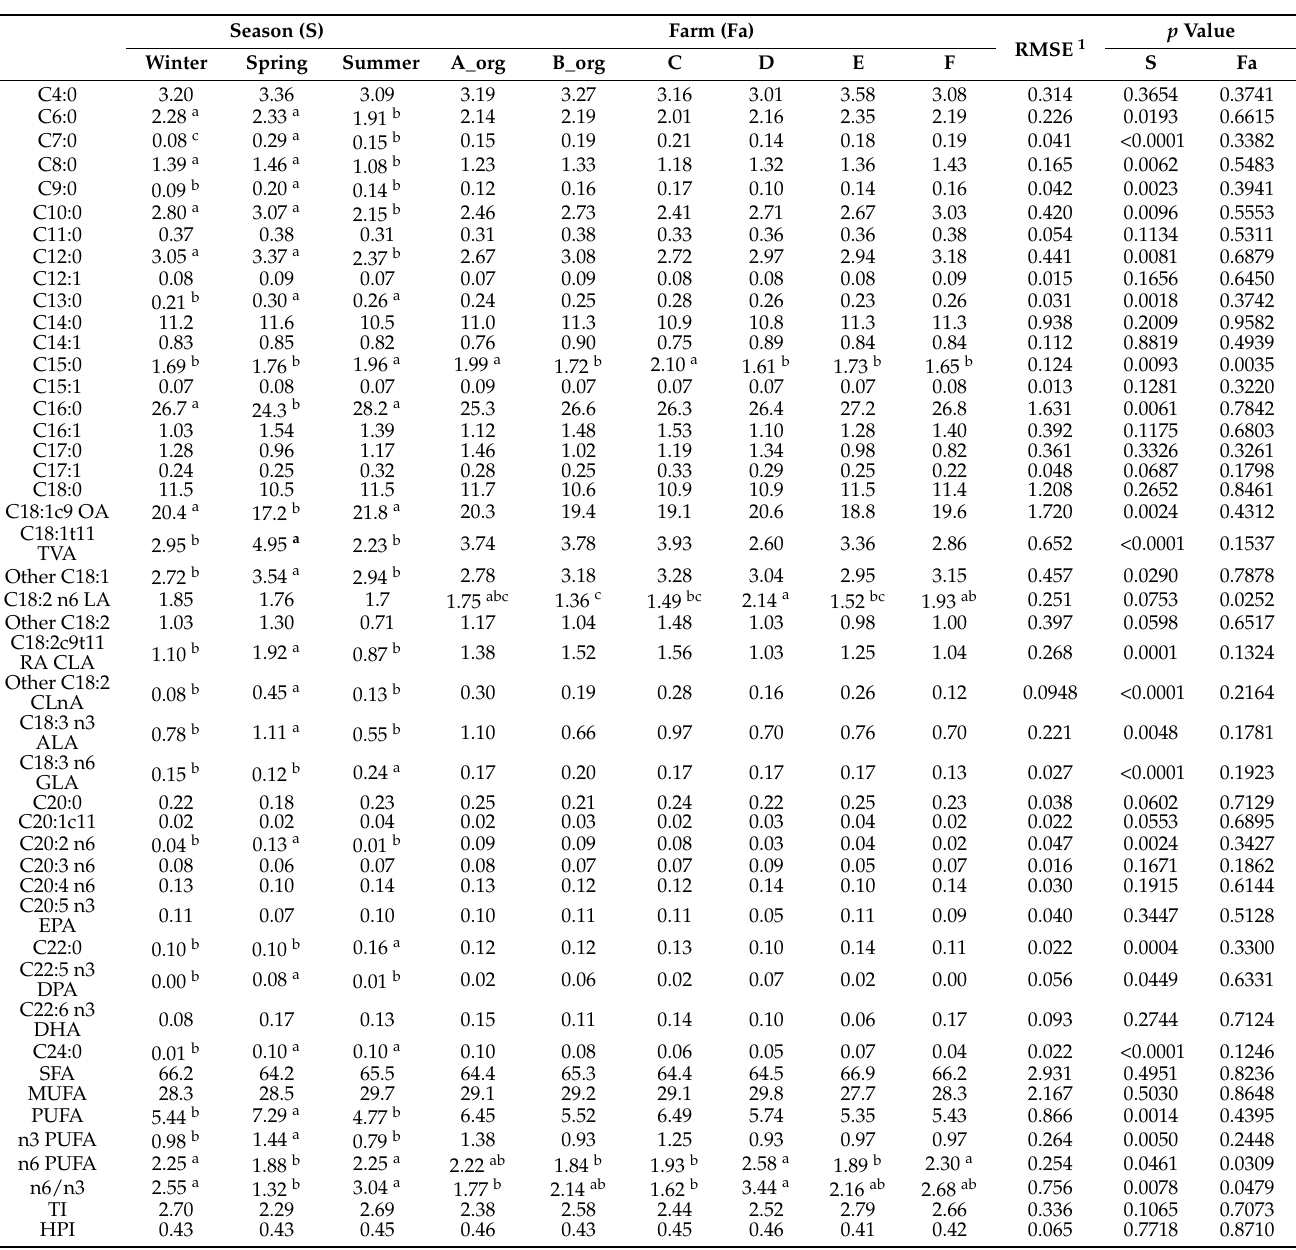
Table 4. Effects of production season and farm on fatty acids profile (g/100 g FA) of Caciocavallo Palermitano